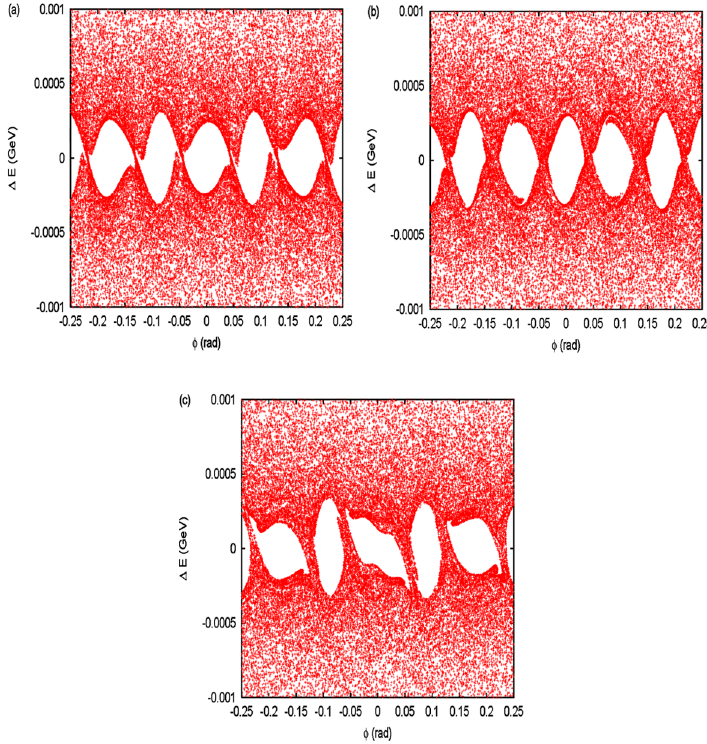
FIG. 7. (Color) (a) Longitudinal phase space of the beam at the end of injection (559 turns) for the chopped beam experiment [same as Fig. 6(b)]. (b) Phase space after 250 turns of storage. (c) Phase space after 650 turns of